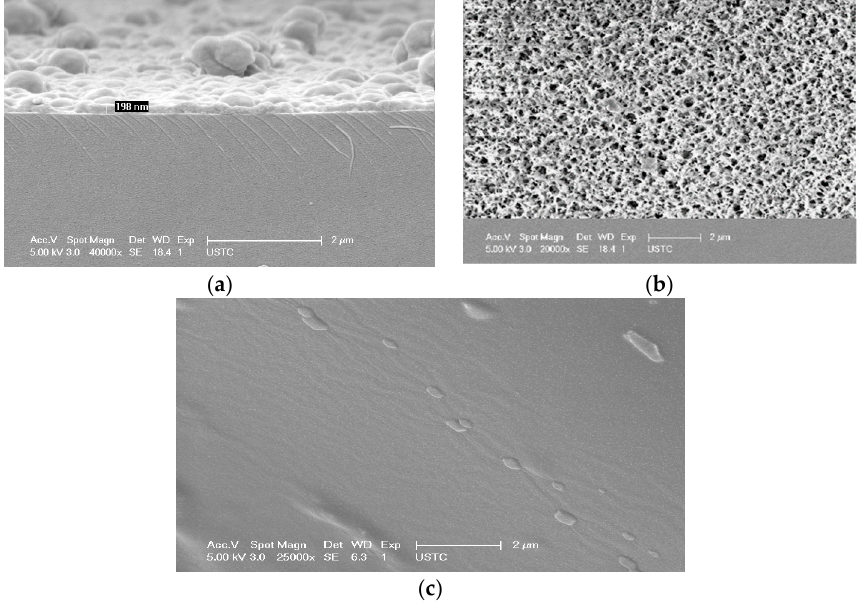
Figure 2. ( a ) the side view SEM of the PSMA-MIP coating sensing unit; ( b ) the top view SEM of the PSMA-MIP coating sensing unit; and ( c ) the top view SEM of the NIP coating sensing unit.